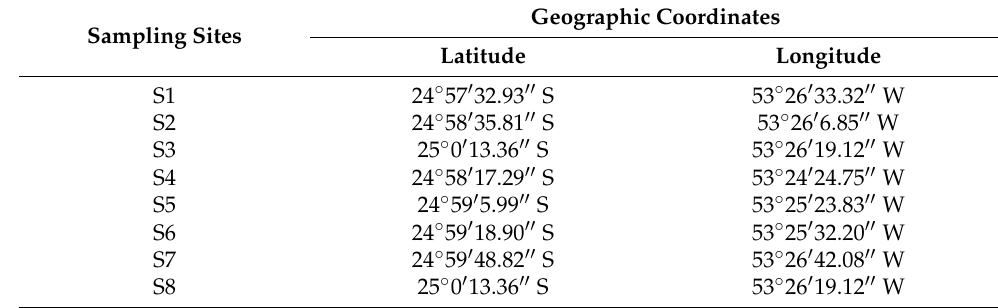
Table 1. Location with geographic coordinates of the collection points along the Cascavel—PR river, Brazil. Sampling Sites